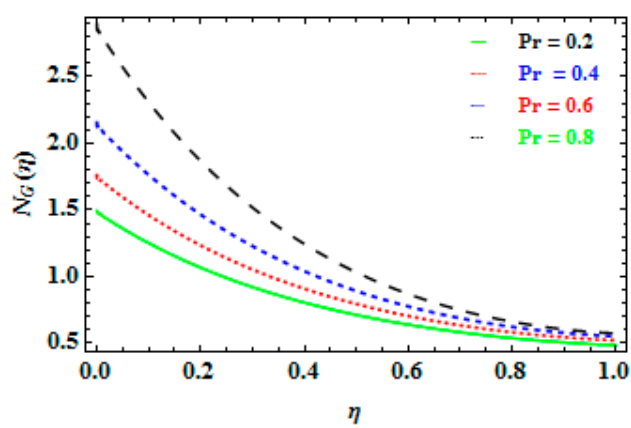
Figure 22. Influence of P r on 𝑁 (cid:3008) ( 𝜂 ) .